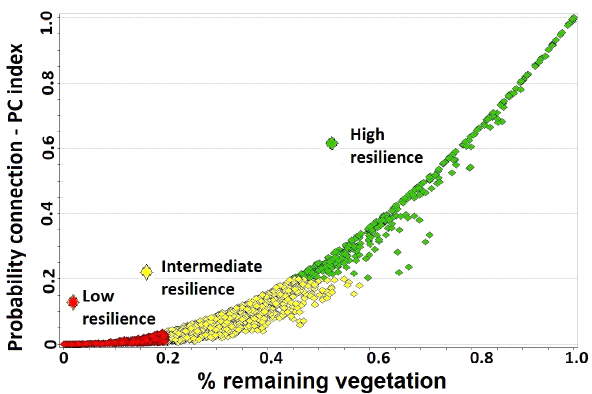
Fig. 3 . Distribution of the 2353 planning units (PUs) according to the habitat amount and landscape connectivity (PC index). Any PUs with less than 20% of habitat cover were considered low resilient (red). PUs with high resilience were those with more than 60% or among 40% and 60% habitat cover with PC index value above average PC index value for this habitat cover interval (green). PUs with intermediate resilience were those between 20% and 40% or less than 60% habitat cover and below average PC index